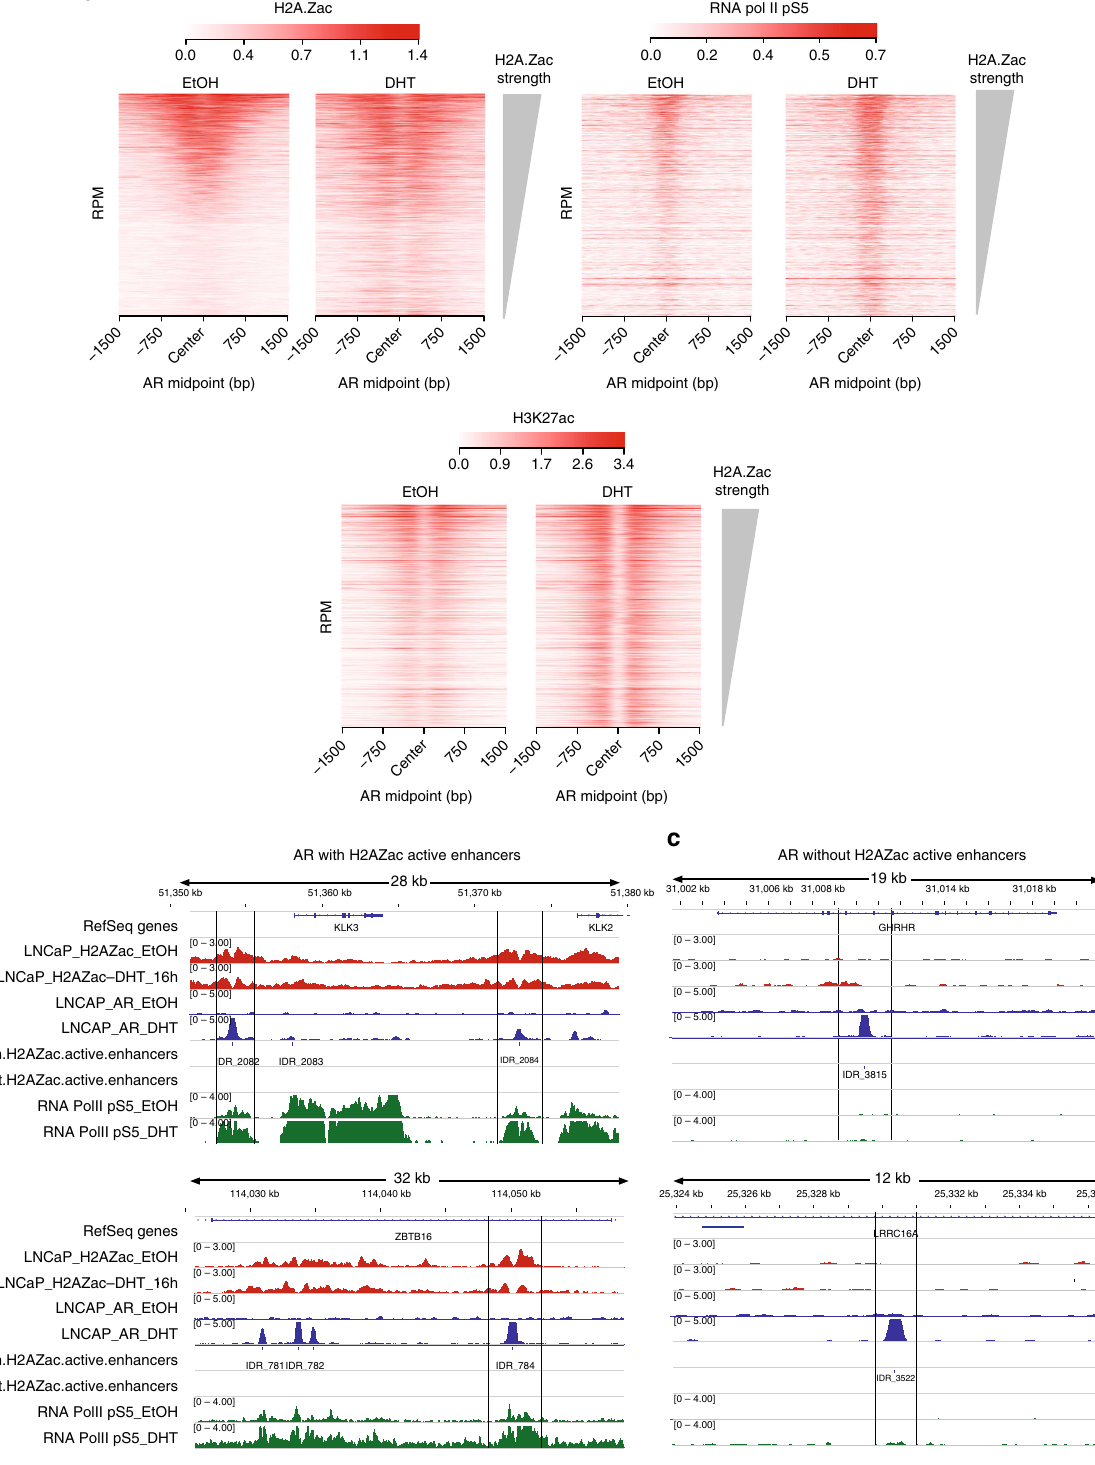
Fig. 7 AR enhancers fl anked by H2A.Zac-nucleosomes have features of active enhancers. a Heatmap of H2A.Zac (LHS), RNA polymerase II phospho S5 (RNA pol II pS5, center) and H3K27ac (RHS) ChIP-seq data at AR enhancers ( n = 2232) ordered by H2A.Zac signal intensity from highest (top) to lowest at starving conditions (EtOH) and DHT treatment (DHT). Scale bars show the colorkey of the intensity of each corresponding ChIP average signal (RPM). b IGV screen shots of representative examples for AR active enhancers with H2A.Zac (LHS) or c without H2A.Zac (RHS) (highlighted in a rectangle) showing H2A.Zac (red), AR (blue) and RNA pol II pS5 (green) ChIP-seq signal at these sites